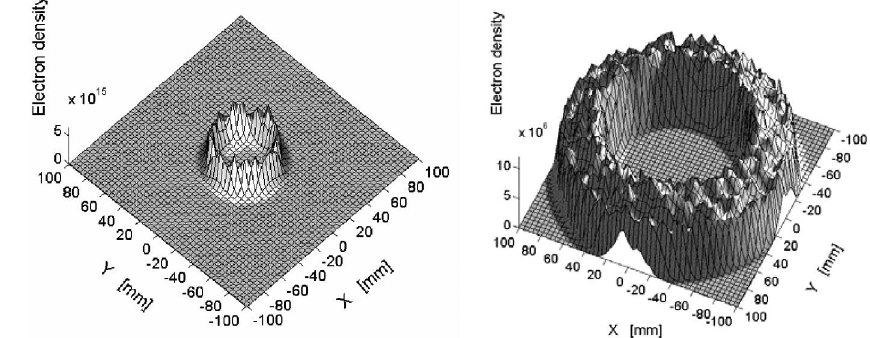
FIG. 12. Electron cloud’s transverse distribution in a 10 G (left panel) and 30 G (right panel) solenoid field during passage through the bunch